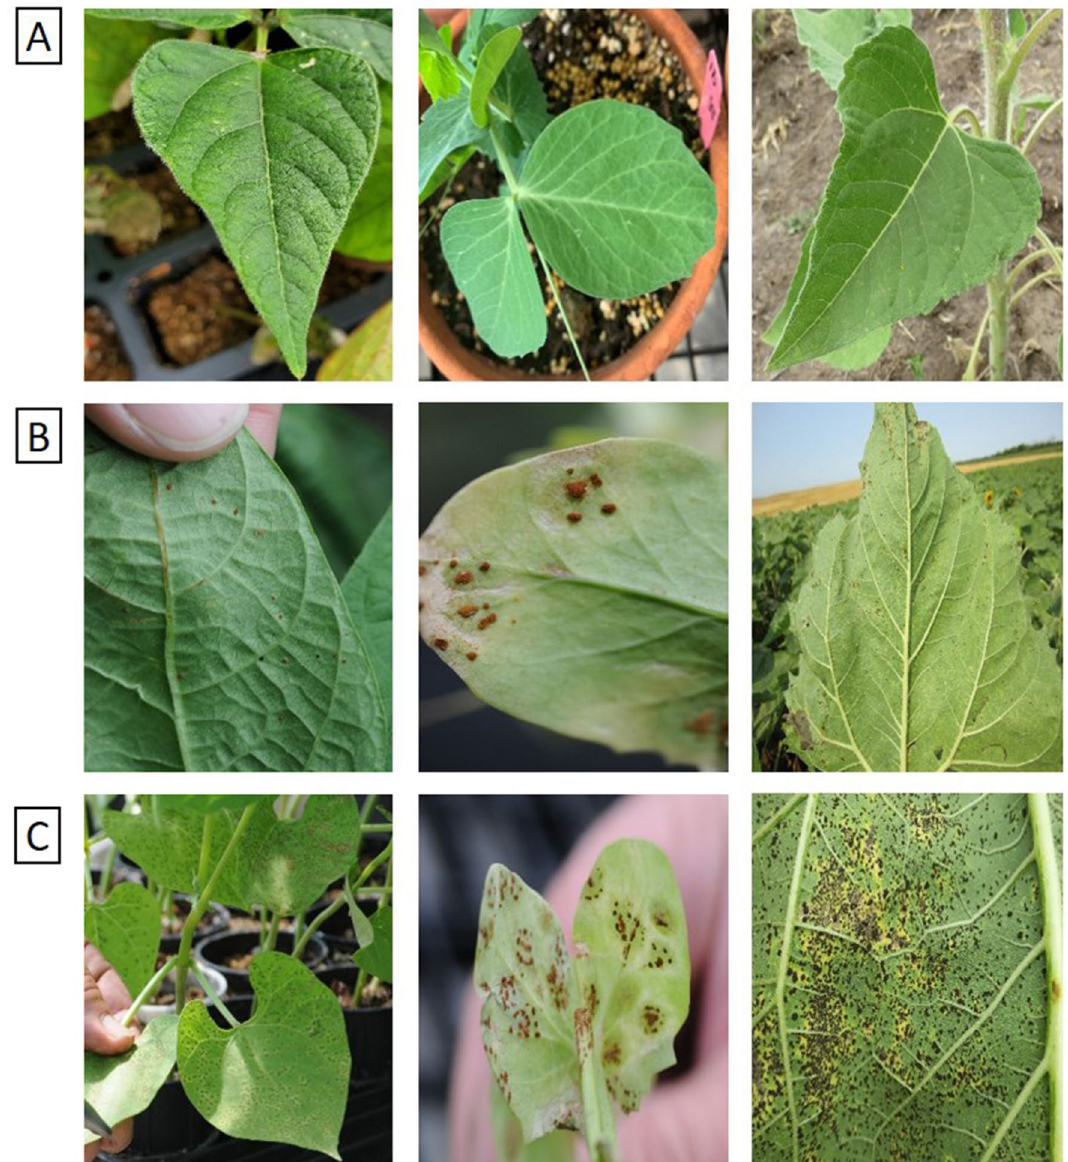
Figure 4. Examples of images used for training the models: ( A ) from left to right: healthy dry bean, field pea, and sunflower leaves, ( B ) from left to right: slightly infected dry bean, field pea, and sunflower leaves, ( C ) from left to right: highly infected dry bean, field pea, and sunflower leaves.